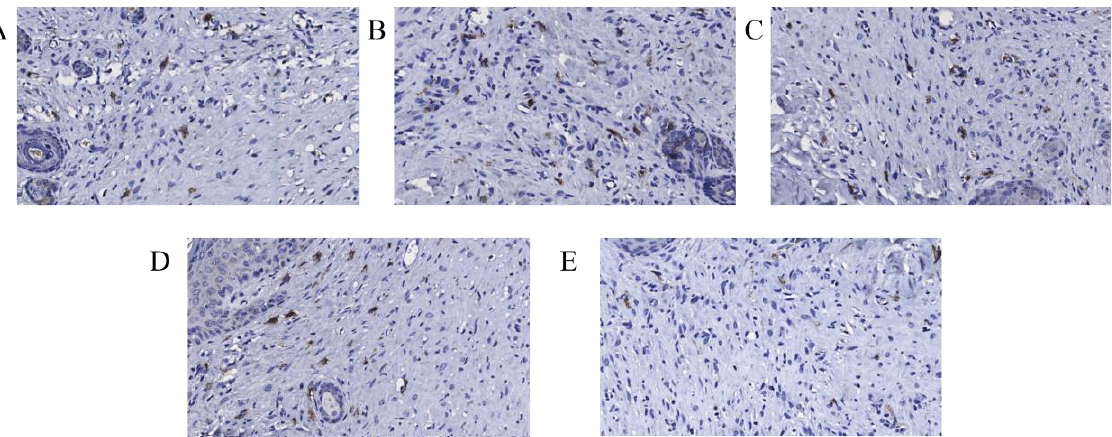
Figure 13. Representative IHC images of regenerated wound tissues with anti-c-kit. ( A ) Model group, ( B ) CS group, ( C ) hydrogel group, ( D ) scolopin2 group, and ( E ) CS-GA-S group ( × 1000 ) .